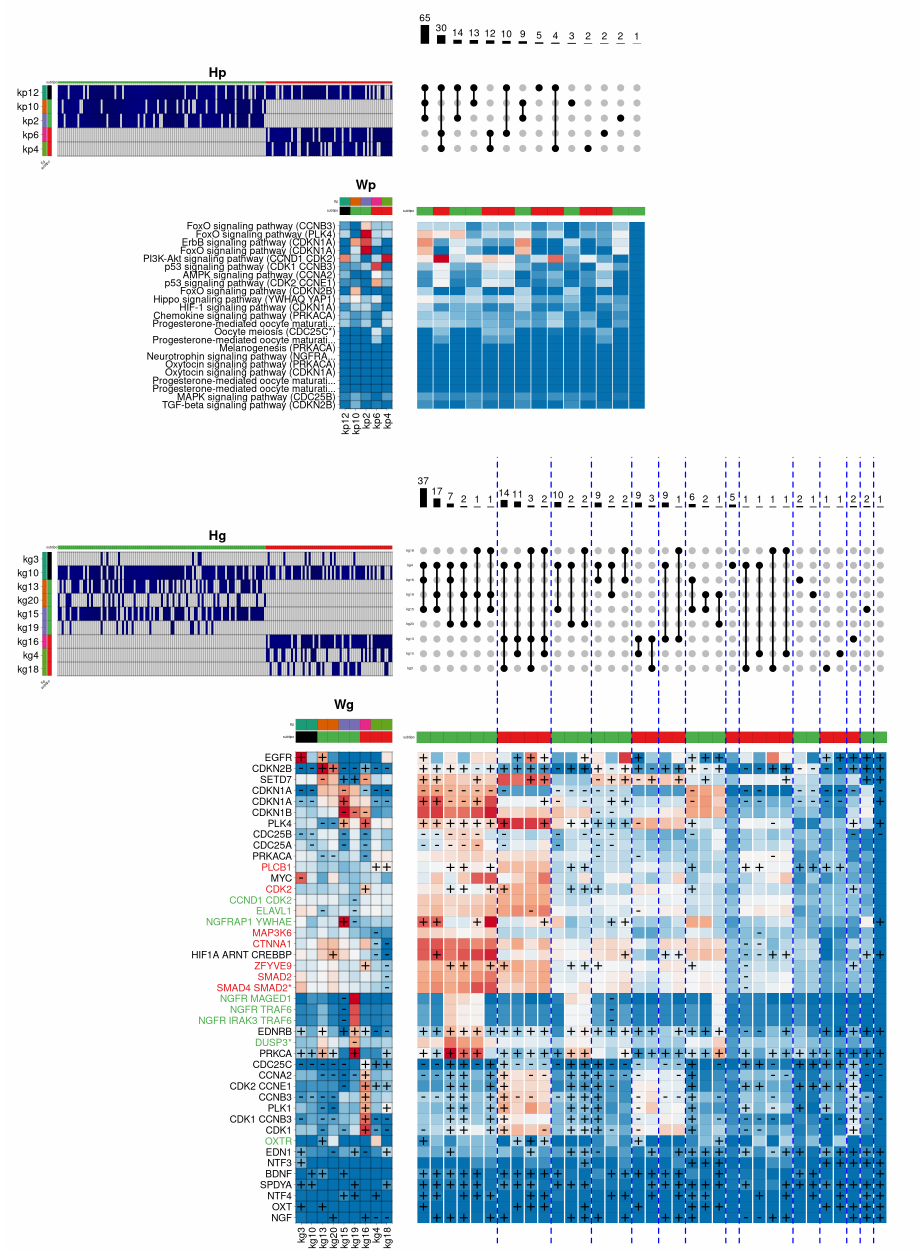
Figure 8. Graphical representation of the hierarchical model obtained in the biological function G2 M transition of mitotic cell cycle , applied to the subtypes Luminal A and Luminal B . The model found two dominant pathway-level combinations concentrating the majority of individuals. Both combinations share the kp12 component (green), that overactivates the PI3K-Akt pathway. Interestingly, the first combination is specific to the Luminal A subtype and adds the kp10 (orange) and kp2 (magenta) components, that activate mainly FoxO and ErbB signalling pathways, and partially the MAPK and TGF-beta pathways. These components are associated in the gene space with the kg13/20 and kg15/19 components, respectively, which characteristically activate the cyclin inhibitors CDKN1A , CDKN1B , and CDKN2B . On the other hand, the second combination is specific to the Luminal B subtype, incorporating the components kp6 (pink) and kp4 (light green), which significantly activate the PI3K-Akt pathway and the P53 protein activation pathway. These components are associated in the gene space with the kg16 and kg4/18 components, activating a set of genes that positively regulates cell proliferation, such as PLK1 , or the cyclins CDC25C , CCNA2 , CDK1 , and CDK2